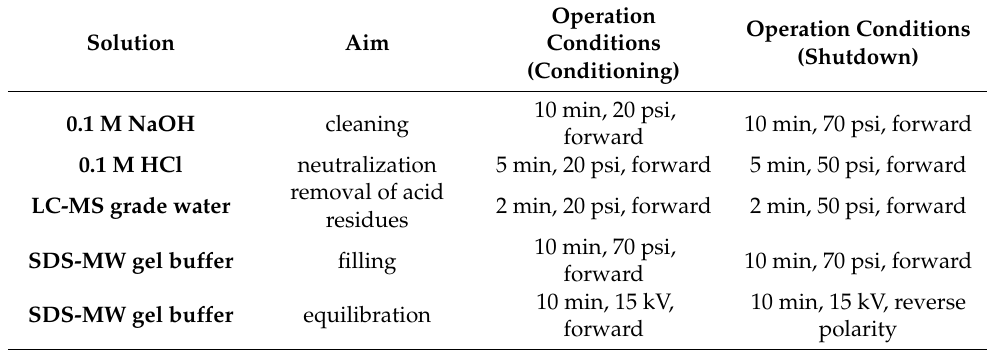
Table 1. Description of the experimental conditions used for conditioning and shutdown methods.